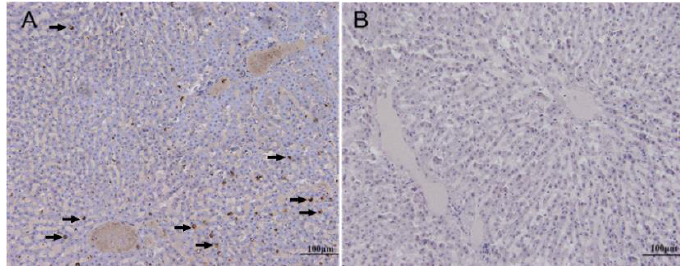
Figure 3. Detection of RHDV VP60 signals in the livers of the dead Alpine musk deer by immunohistochemistry. Incubation with the primary antibodies against VP60 ( A ), positive signals are indicated by arrow; incubation without the primary antibody as the control ( B ). Viruses 2020 , 12 , x FOR PEER REVIEW